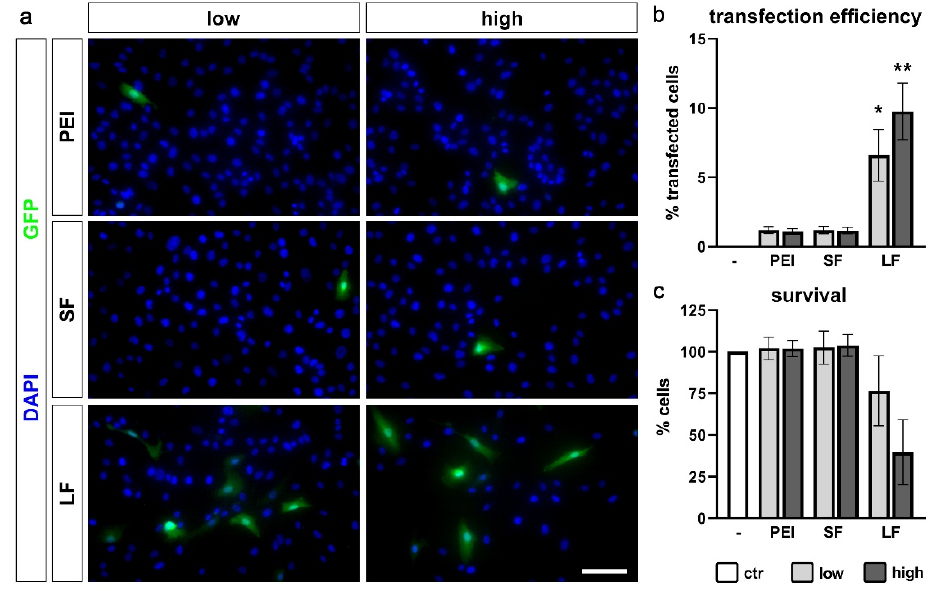
Figure 5. Transfection e ffi ciency of PDL-hTERT cells. Cells were transfected with PEI, SuperFect (SF) and Lipofectamine 2000 (LF) in low and high amounts. ( a ) Representative images of GFP-positive transfected cells (green) and DAPI-stained nuclei of all cells (blue). Scale bar: 100 µ m. ( b ) Quantification of transfection e ffi ciency. GFP-positive transfected cells per field of view were set in relation to the number of DAPI-positive cell nuclei per field of view and are presented as % ± SEM. Untransfected cells served as control (ctr). ( c ) Cell viability was calculated by counting DAPI-positive nuclei per field of view and set in relation to DAPI-positive nuclei per field of view of untransfected cells (ctr) and are presented as % ± SEM. n = 3 biological replicates performed as triplicates with three analyzed photographs per singlet. * 0.01 ≤ p < 0.05, ** 0.001 ≤ p < 0.01.